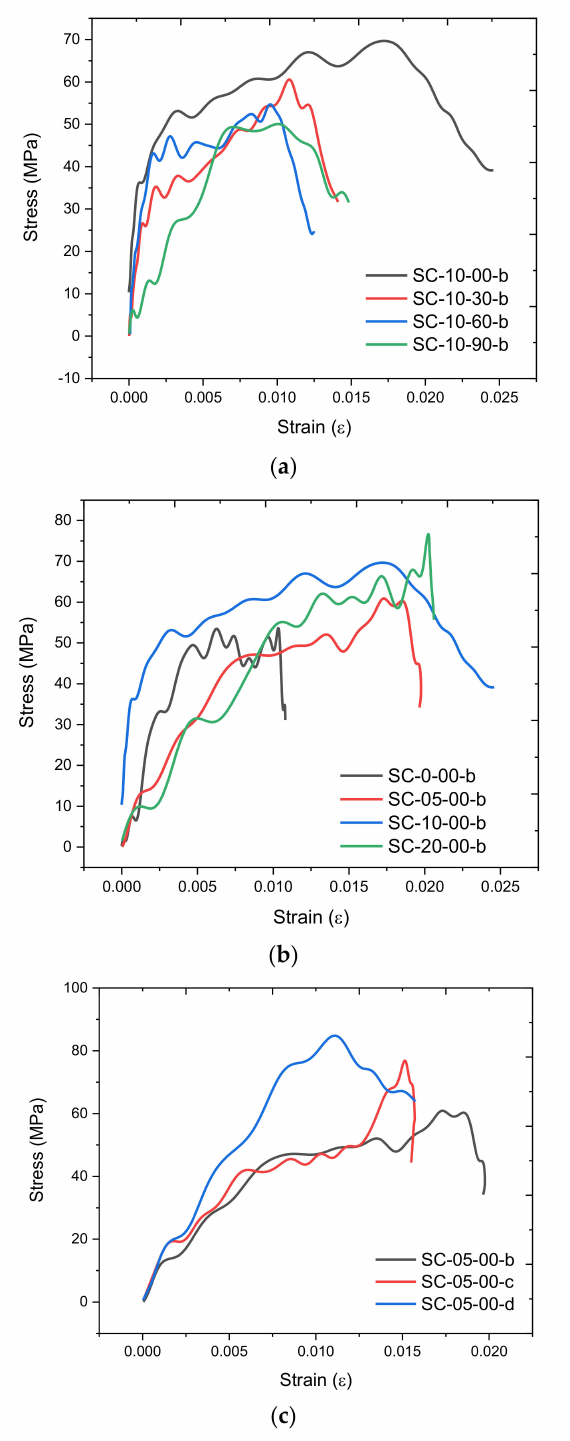
Figure 5. Stress–strain curves of concrete samples. (Note: sample was labeled as SC-XX-YY-Z, where XX denotes the fiber content, with 0, 05, 10 and 20 representing fiber contents of 0%, 0.5%, 1.0% and 2.0%, respectively. YY denotes the corrosion duration, with 00, 30, 60 and 90 denoting corrosion duration of 0 days, 30 days, 60 days and 90 days, respectively. Z denotes the strain rate level, with b, c and d representing strain level of 20 s − 1 , 50 s − 1 and 100 s − 1 , respectively.) ( a ) Strain rate = 20 s − 1 , steel fiber content = 1.0% under different corrosion durations, ( b ) strain rate = 20 s − 1 , corrosion duration = 0 days with different fiber contents, ( c ) corrosion duration = 0 d, fiber content = 0.5% under different strain